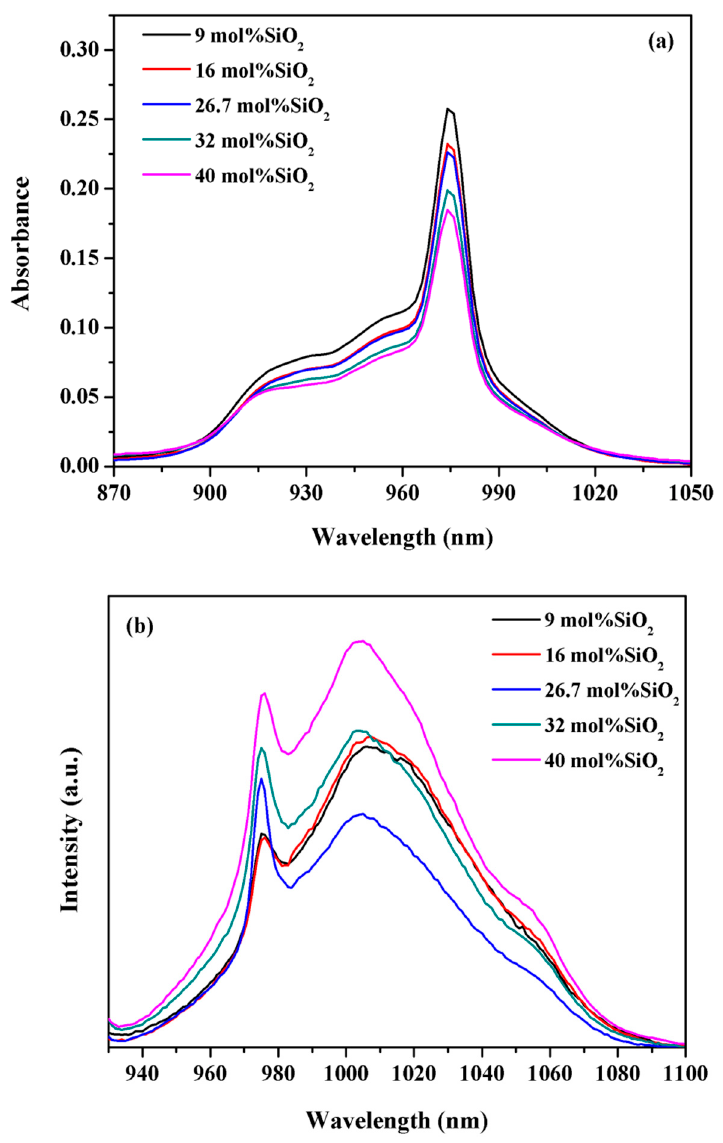
Figure 1. Absorption ( a ) and emission ( b ) spectra of 20BaO-(80- x )P 2 O 5 - x SiO 2 -1Yb 2 O 3 ( x = 9, 16, 26.7, 32, and 40 mol %, respectively) glasses.